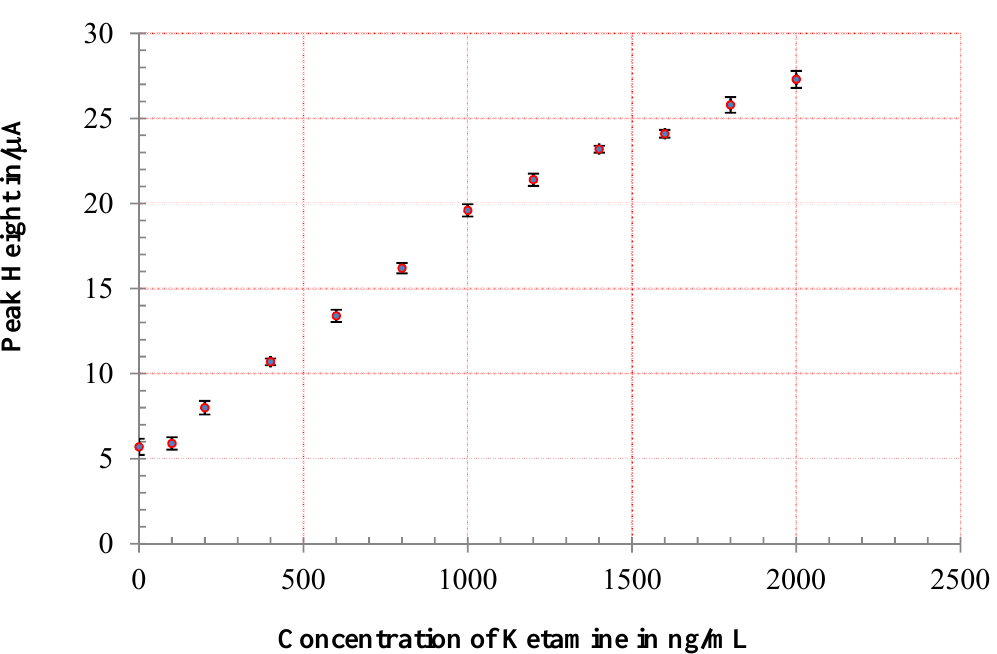
Figure 5. A calibration plot corresponding to the addition of Flunitrazepam into an unmodified Gordon Gin & Tonic solution over the concentration range 200–2,000 ng/mL. Also included are error bars (N